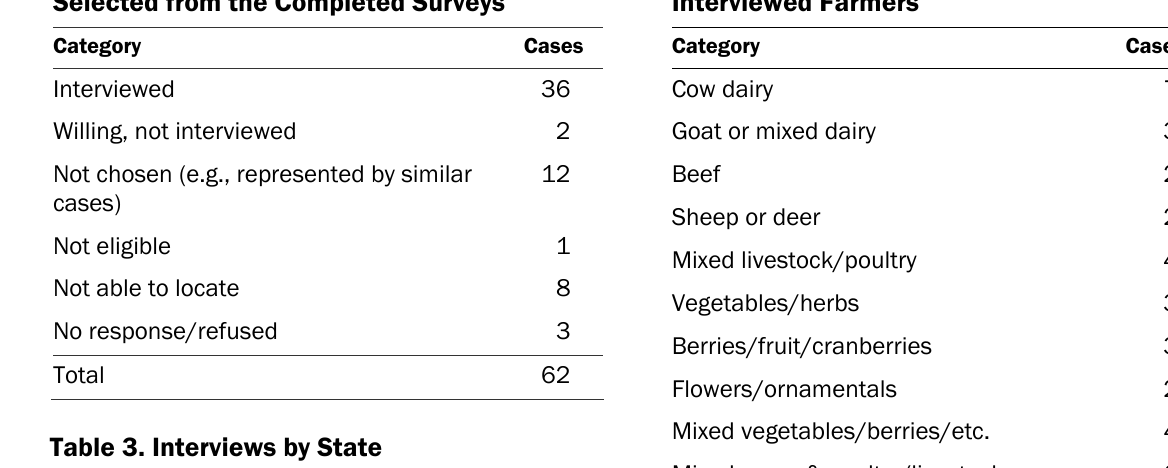
Table 4. Main Enterprise Type of